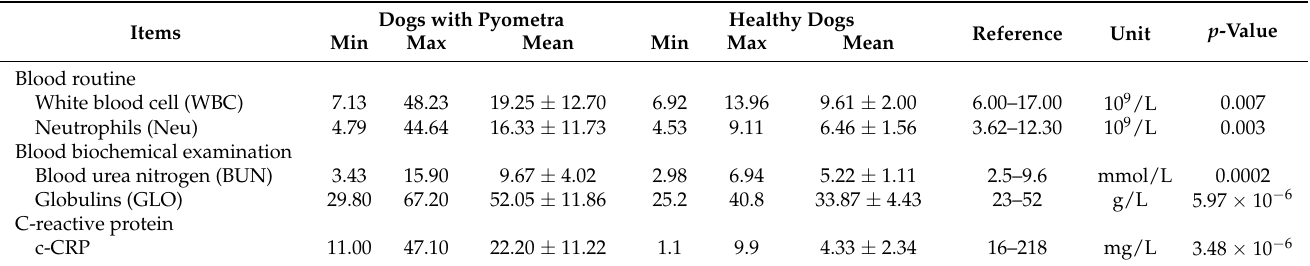
Table 2. The blood examinations of diseased dogs with pyometra and healthy